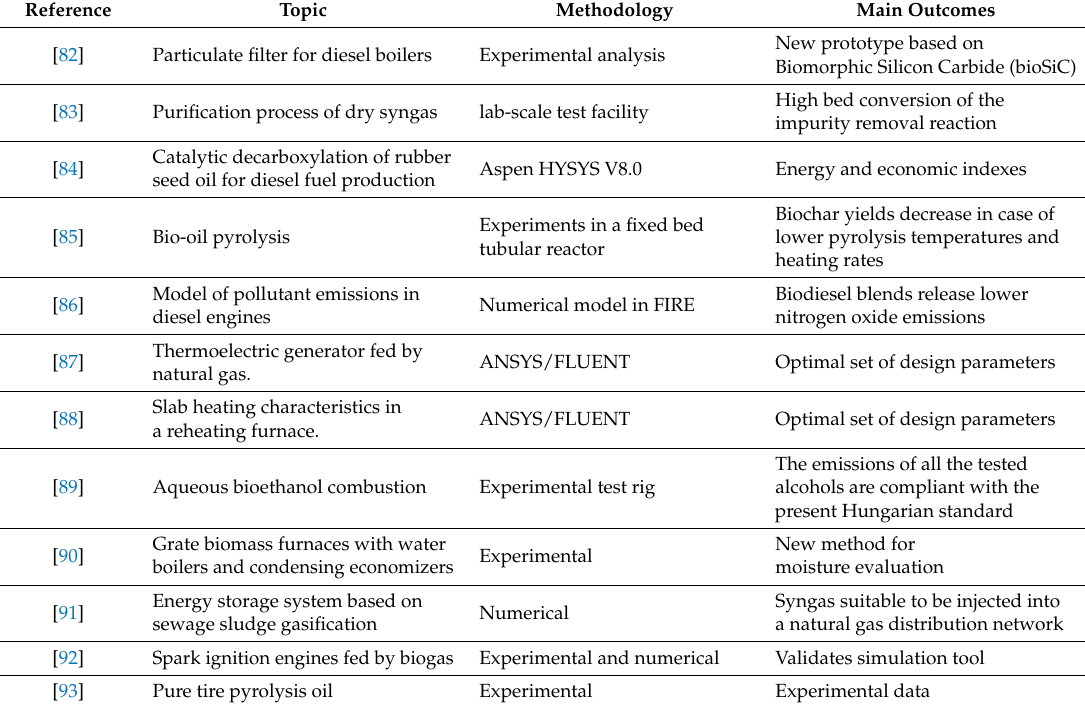
Table 3. Main topics, methodologies and outcomes of the previous SDEWES papers dealing with advanced combustion techniques and